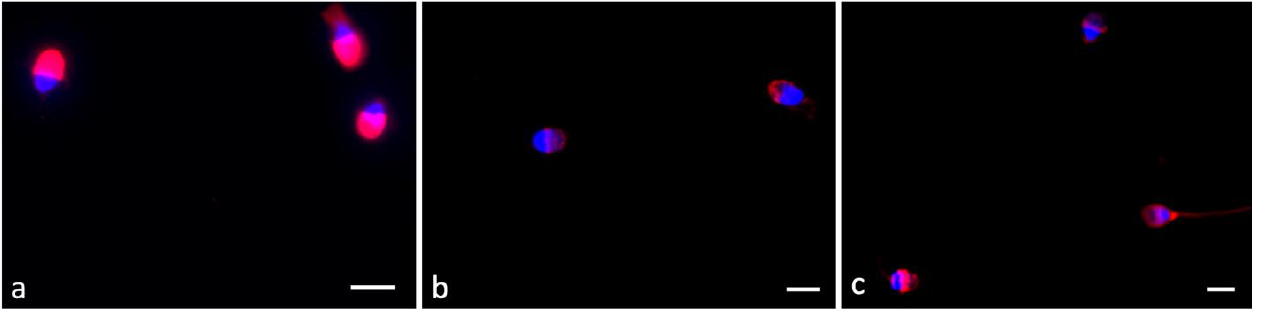
Figure 1. Evaluation of the acrosome status with TRITC – pisum sativum agglutinin (TRITC – PSA). Intact acrosome ( a ), reacted or partially reacted acrosome ( b , c ) with no fluorescence or only fluorescence of the equatorial segment and loss of acrosomal membranes. Bars: 6 μM.